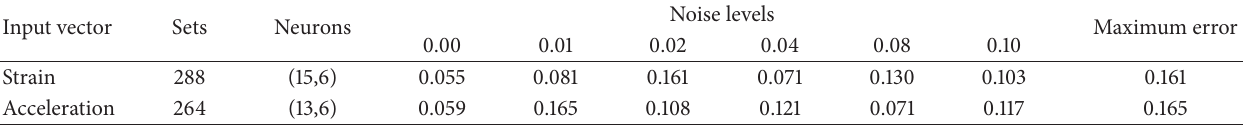
Table 20: The identification errors of the forecasted cases based on optimal neural networks.